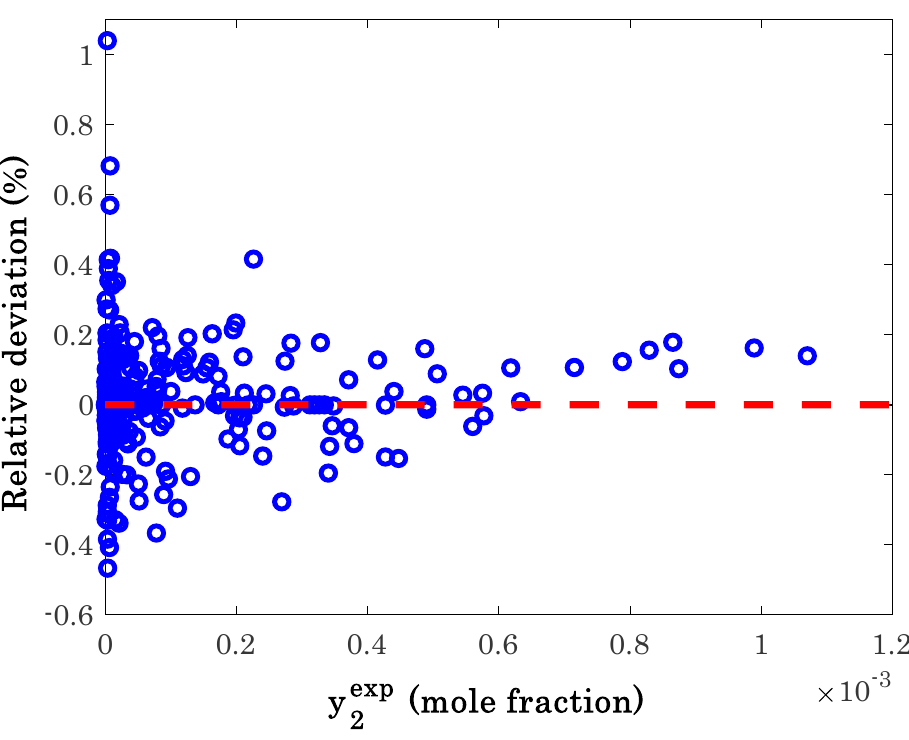
Figure 8. The observed relative deviations for estimating each experimental measurement of anti-cancer drug solubility in supercritical carbon